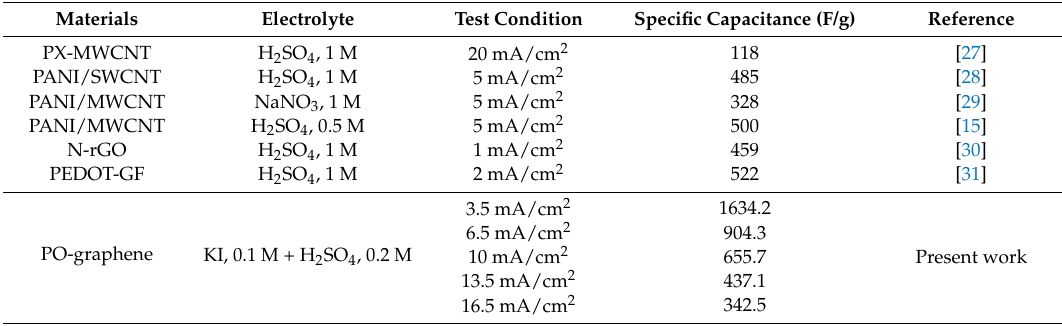
Table 1. Comparison of discharge specific capacitance between the phosphorus oxide modified graphene (PO-graphene) and other reported